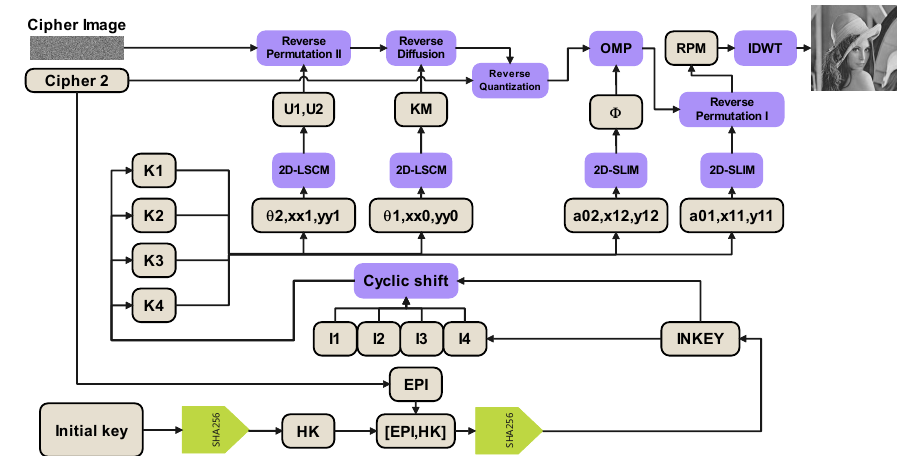
Figure 2. The block diagram of the decryption